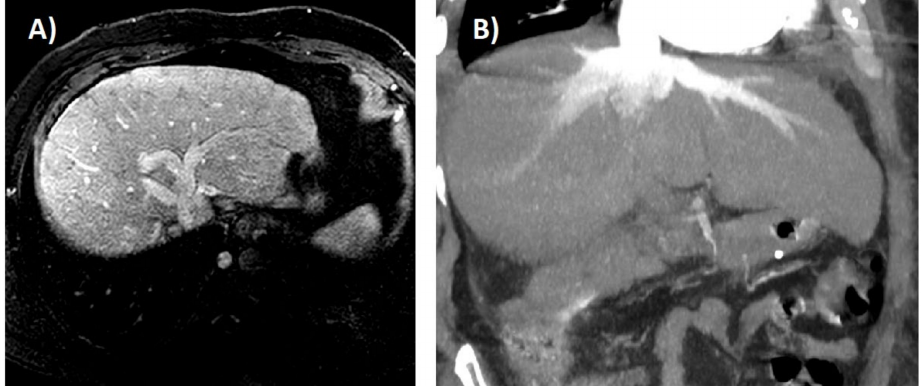
Figure 3. ( A ) Idiopathic membranous inferior vena cava obstruction in a 44-year-old man. Magnetic resonance imaging shows a mildly nodular liver with altered parenchymal perfusion and dilatation of hepatic veins. ( B ) Severe tricuspid regurgitation in a 49-year-old man. Computed tomography scan shows dilatation of hepatic veins and reflux of contrast into the inferior vena cava and hepatic veins.